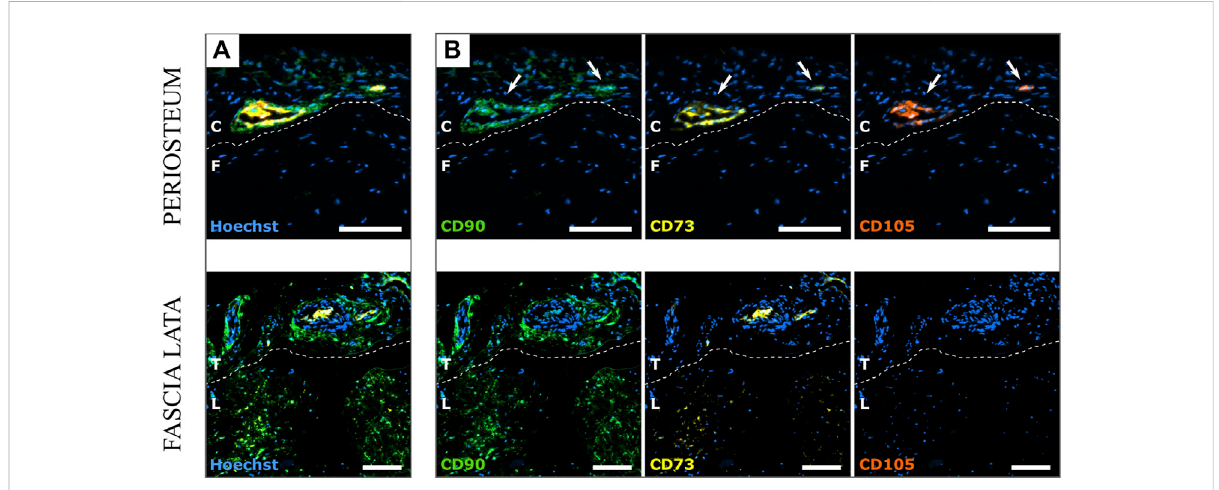
FIGURE 7 ComparisonoftheHPandHFLbymultipleximmunohistochemistrywithtyramidesignalampli fi cationforCD90,CD73andCD105withmerged signals (A) or separate signals (B) . Blue: Hoechst, Green: CD90, Yellow: CD73, Red: CD105. White arrows show the simultaneous presence of the 3 signals on the same location. C: cambial layer, F: fi brous layer, L: longitudinal layer, T: transverse layer. White scale bars: 100 µm.